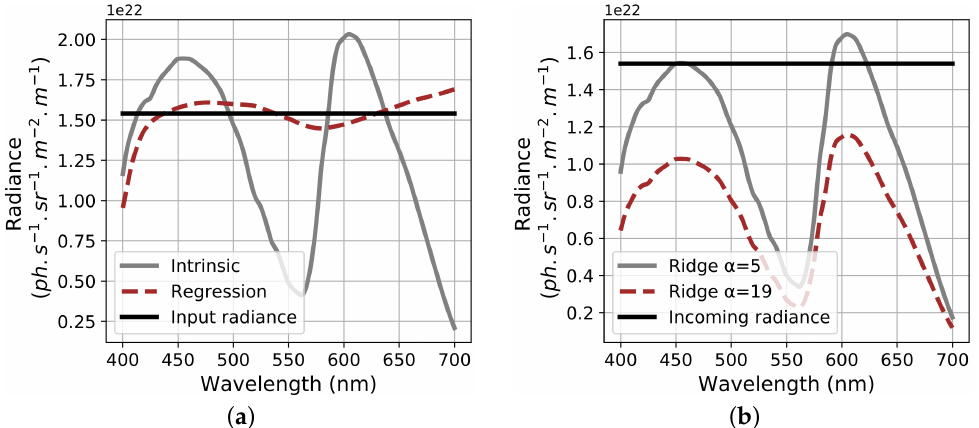
Figure 14. ( a ) Input radiance with corresponding reconstruction for intrinsic and regression methods, ( b ) reconstruction using ridge regression with two different α parameters.